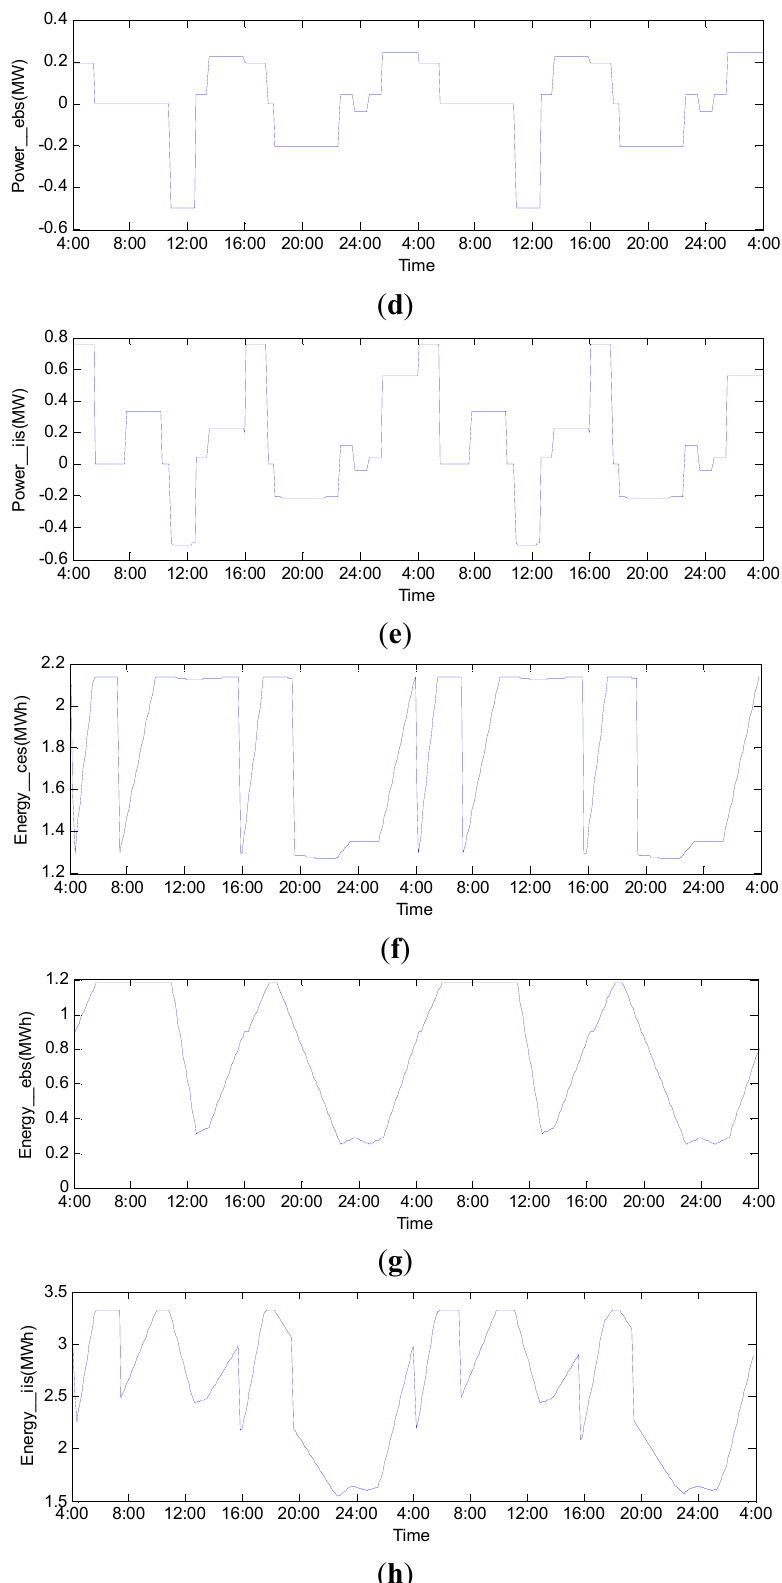
Figure 12. Simulation results of the proposed charging/discharging strategy. ( a ) load curve; ( b ) energy curve of EVs; ( c ) charging/discharging power of CES; ( d ) charging/discharging power of EBS; ( e ) charging/discharging power of IIS; ( f ) energy capacity of CES; ( g ) energy capacity of EBS; ( h ) energy capacity of